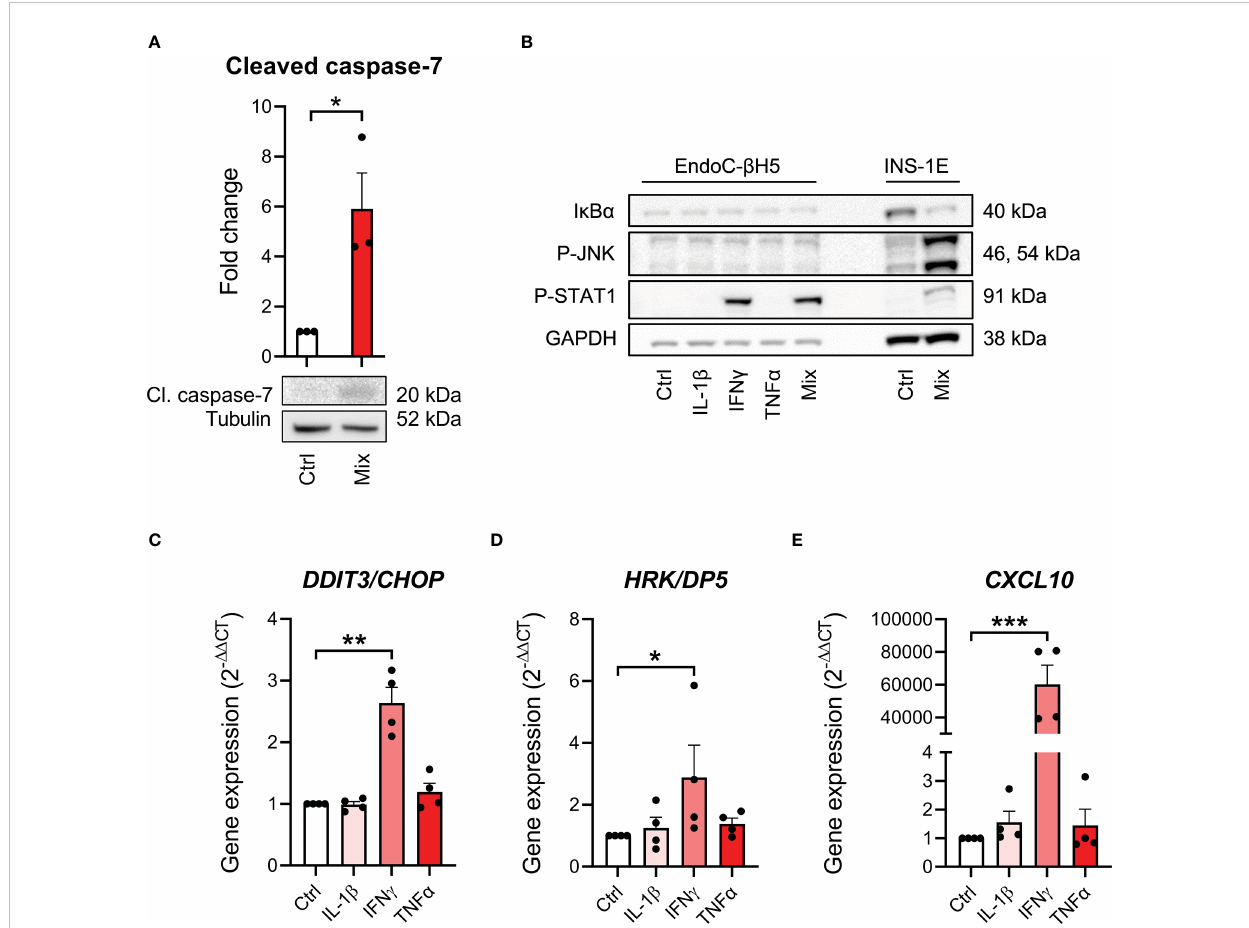
FIGURE 2 Cytokine-induced signal transduction in EndoC- b H5 cells. (A) Immunoblotting of cleaved caspase 7 following exposure to cytokines (50 U/mL IL-1 b , 1000 U/mL IFN g and 1000 U/mL TNF a ) (Mix) for 96 h. Tubulin was used as loading control (n=3). (B) Immunoblotting of I k B a , phosphorylated STAT1, and phosphorylated JNK following exposure to cytokines (50 U/mL IL-1 b , 1000 U/mL IFN g and 1000 U/mL TNF a ) alone or in combination (Mix) for 30 min. GAPDH was used as loading control. Representative image (n=3). Lysates from INS-1E cells with/without cytokine exposure were used as positive control. Gene expression of (C) DDIT3 / CHOP , (D) HRK / DP5 and (E) CXCL10 in cells exposed to individual cytokines for 48 h. GAPDH was used as housekeeping gene. Data are means ± SEM (n=4), *p<0.05, **p<0.01, ***p<0.001. Ctrl, untreated